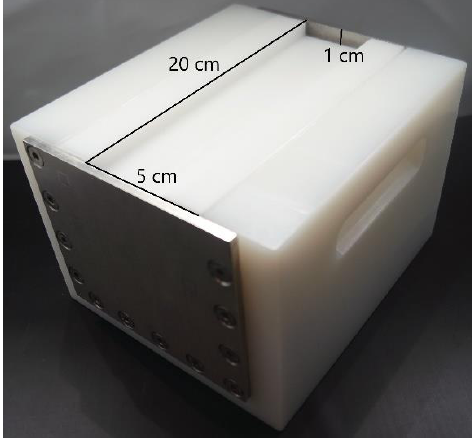
Figure 1. The PEF cell and the dimensions of the treatment chamber used. The PEF system created monopolar pulses with rectangular decay. Four different parameters were varied, i.e., voltage (V), pulse number (n), frequency (Hz), and pulse width (µs), using a 2 4 full factorial plan, supplemented with center points. The high-